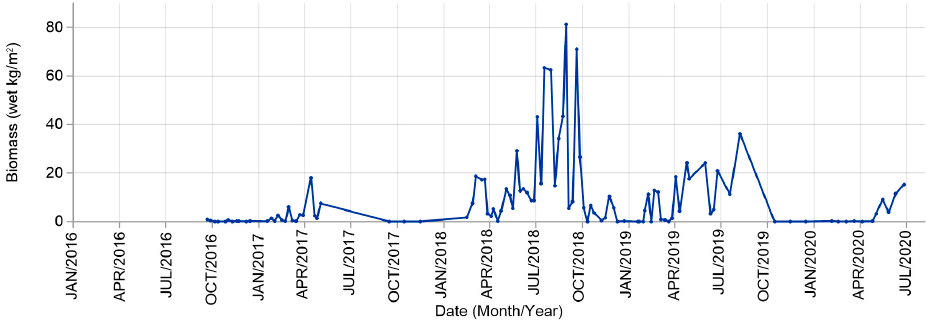
Figure 6. Biomass of beached sargasso on a short section of beach at Puerto Morelos (adapted from [8] ).